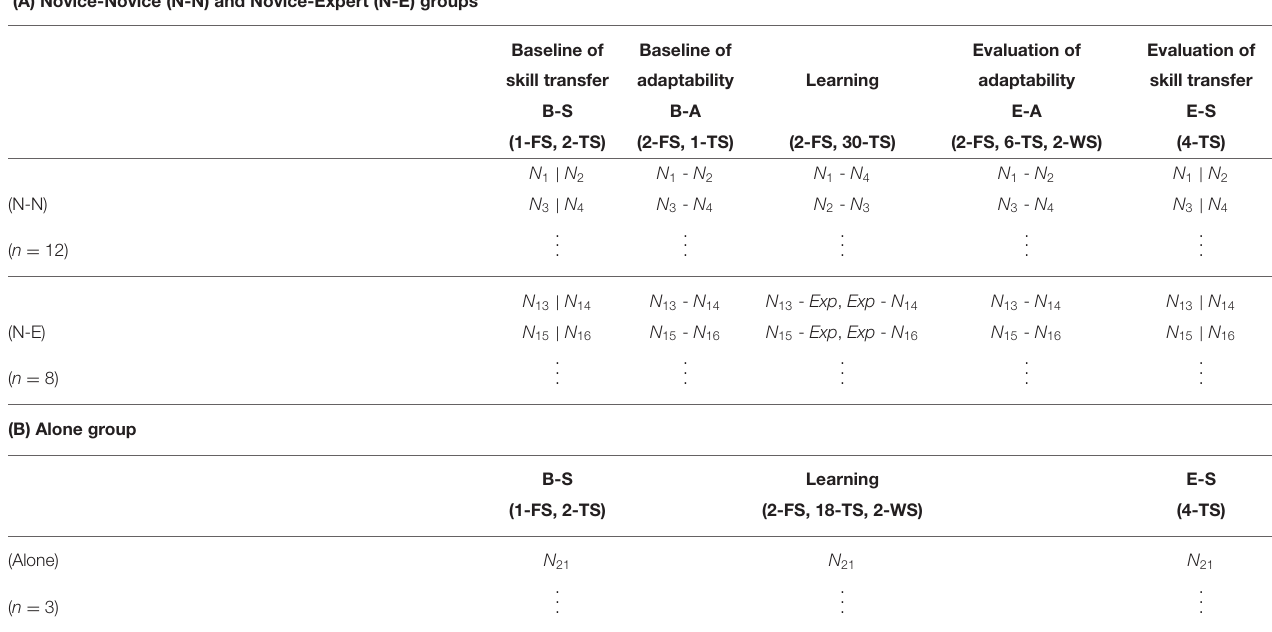
TABLE 1 | Experimental